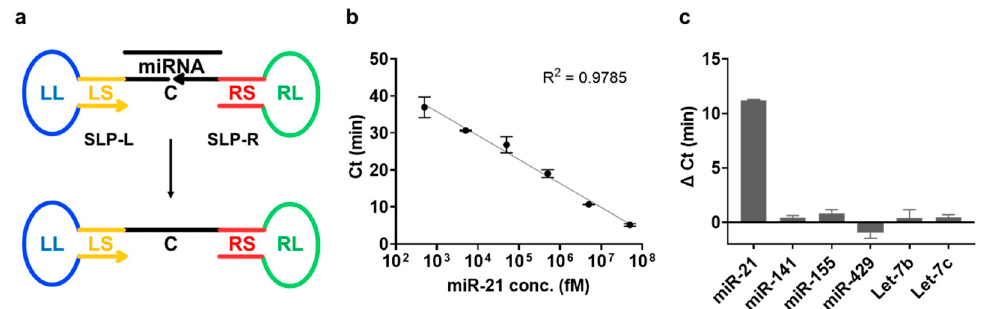
Figure 7. Detection of target miRNA using low-temperature LAMP in combination with a ligation reaction. ( a ) Schematic illustration of DNA ligation catalyzed by SplintR ligase for the detection of a target miRNA. ( b ) Standard curve of the Ct values at different miR-21 concentrations. ( c ) Specificity of low-temperature LAMP for the detection of the target miRNA. The Δ Ct values refer to the difference between the Ct value of each miRNA and the Ct value of NTC. The concentration of miRNA was 500 pM. All tests were performed with three technical